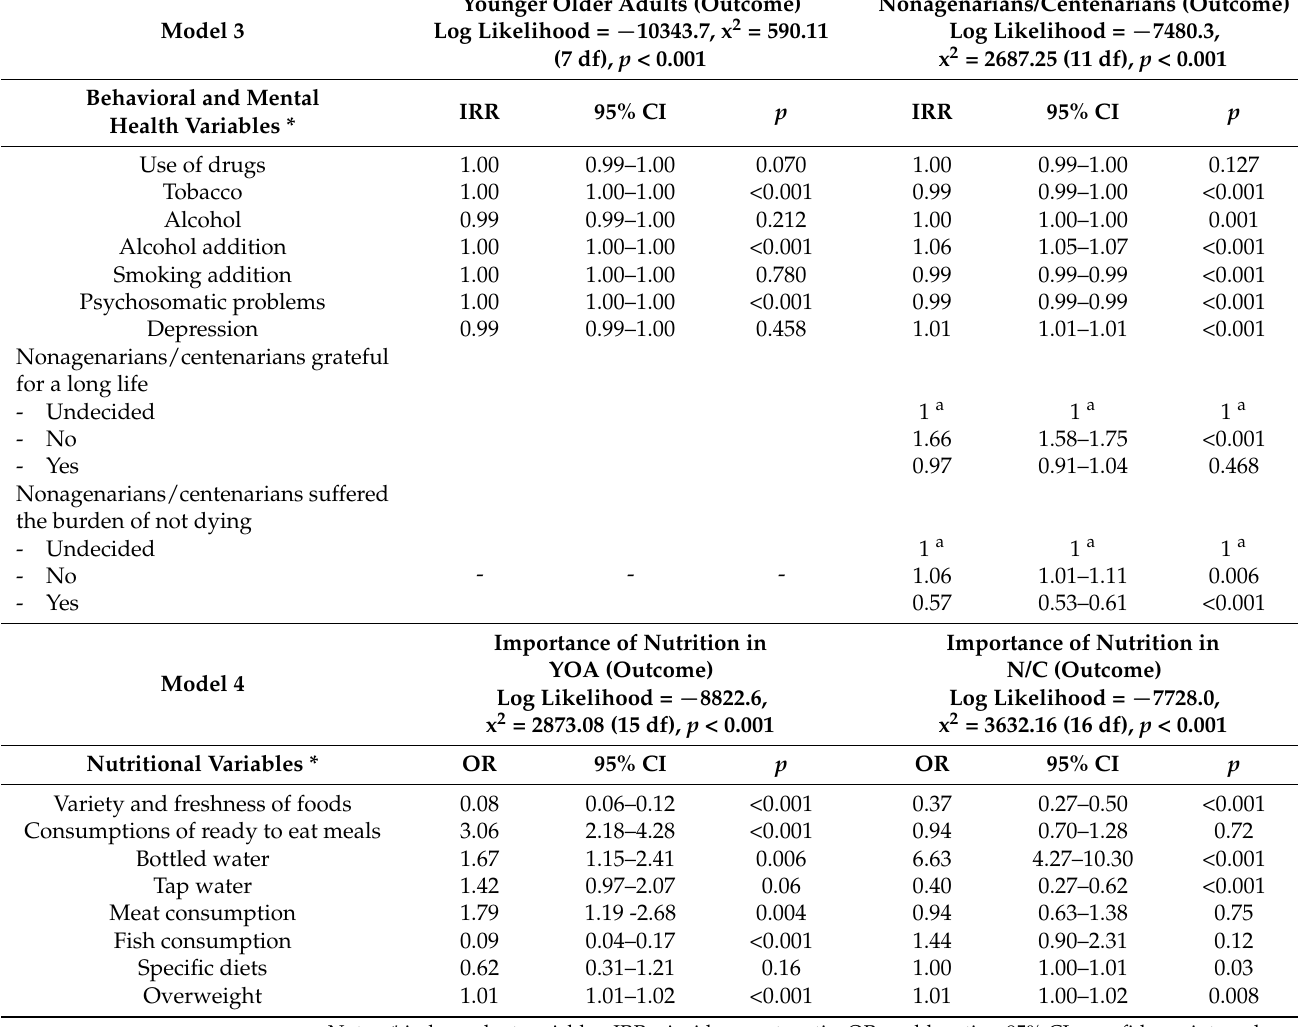
Table 2. Behavioral, lifestyle, and nutritional variables of the young older adults and the nonagenari-